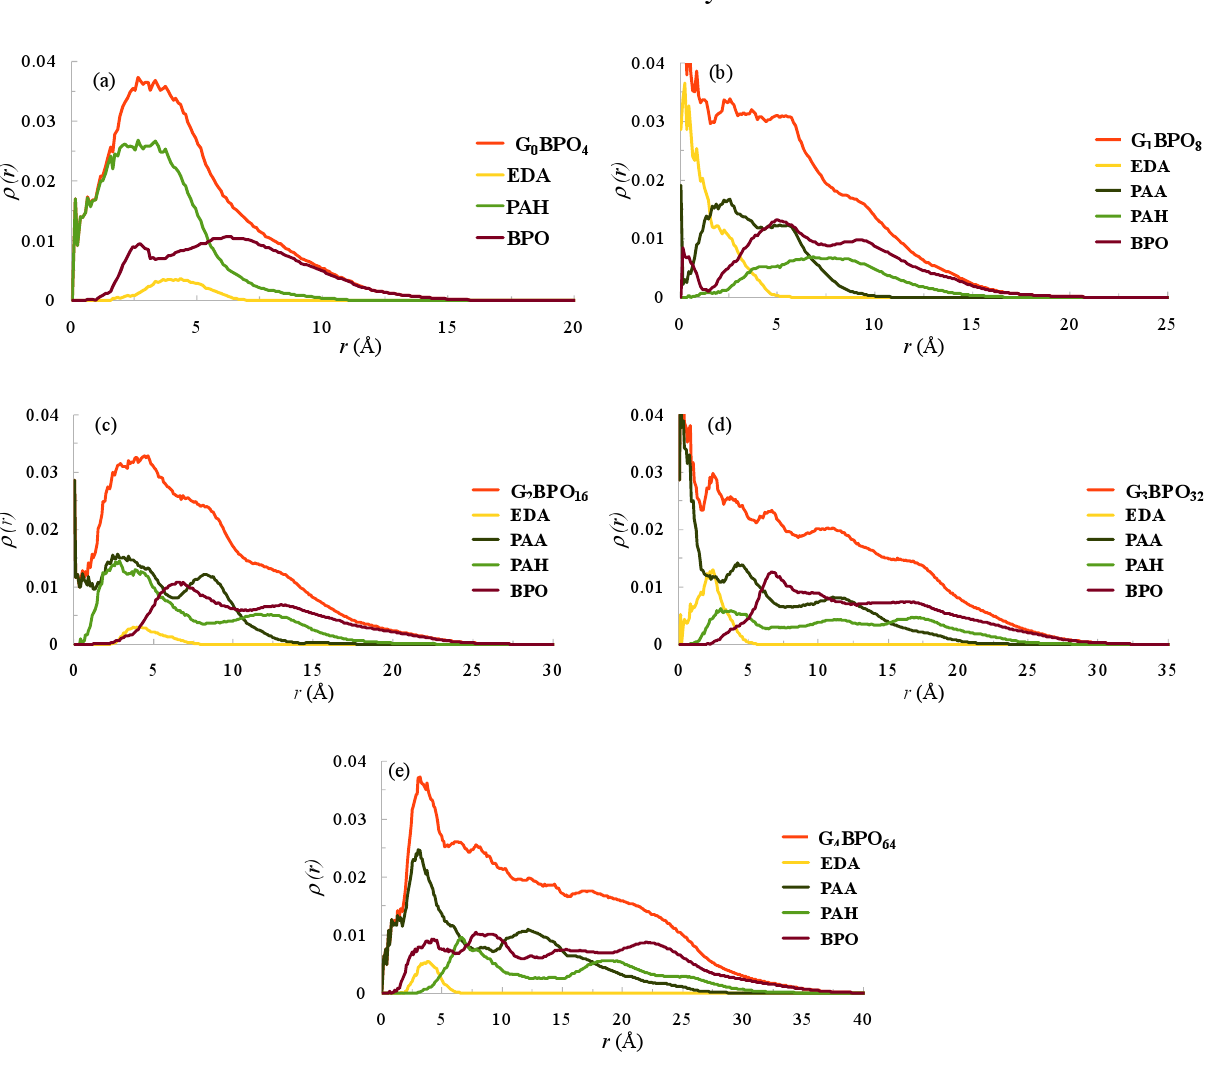
Figure 11. Density distributions of dendrimer and its monomers with respect to the center-of-mass of the dendrimer for all the examined